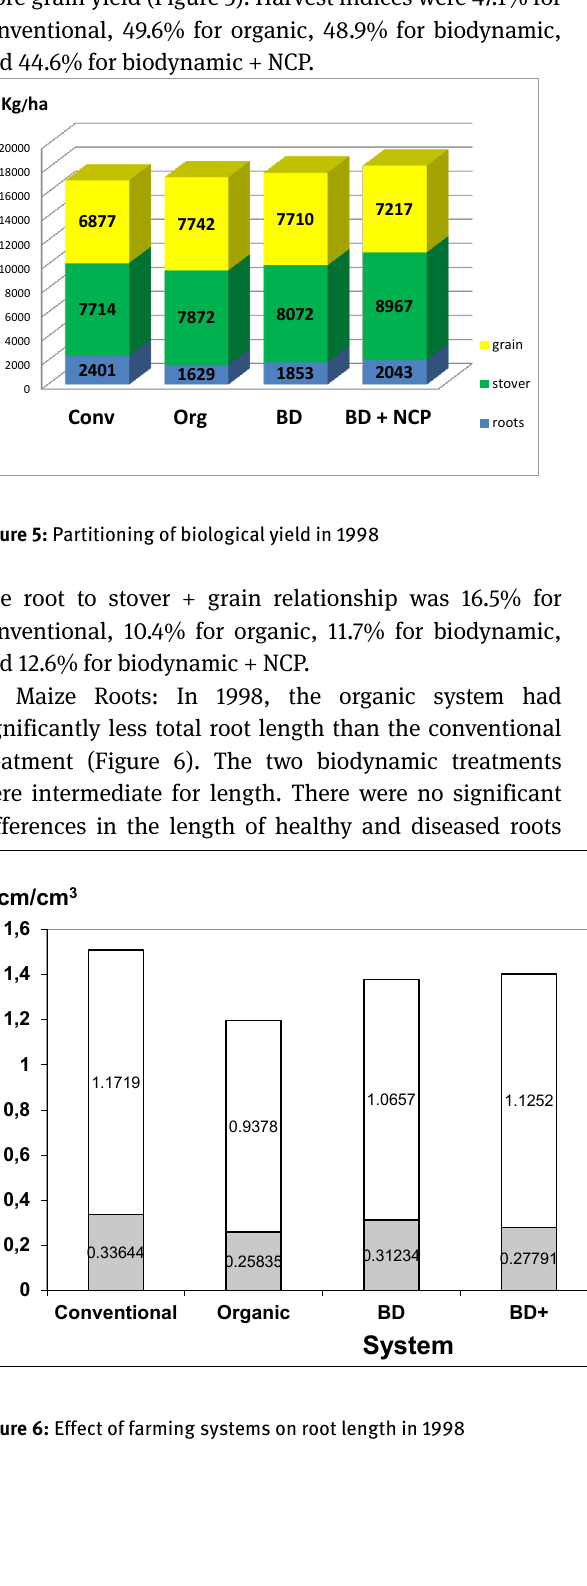
Figure 6: Effect of farming systems on root length in 1998